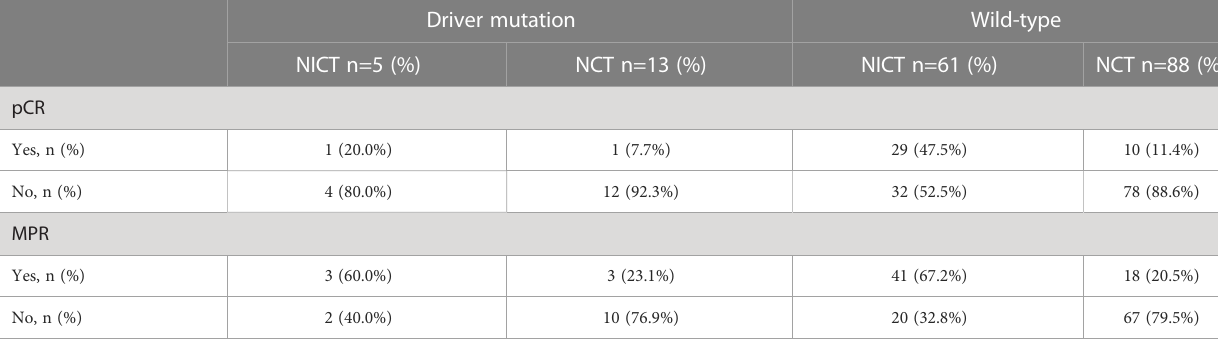
TABLE 6 Pathological response of patients with driver mutations and